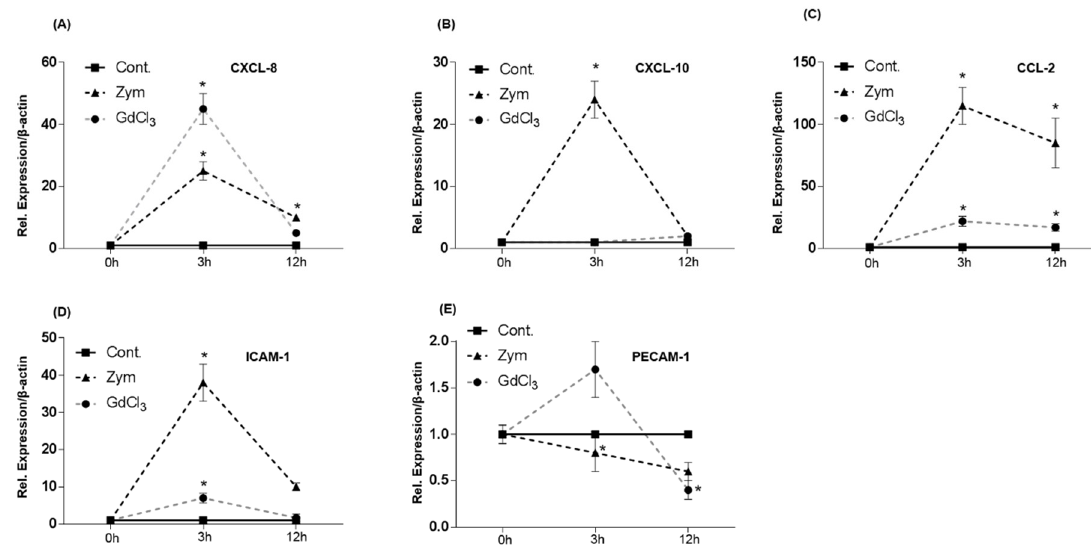
Figure 8. Fold change of mRNA expression of CXC-, CC-chemokines and adhesion molecules in intraperitoneally administrated GdCl 3 and Zymosan C3H/HeJ mice livers at different time points relative to controls. Maximum increase of CXCL-8 ( A ), CXCL-10 ( B ) and CCL-2 ( C ) gene expression is detected at 3 h by RT-PCR. Maximum increase of ICAM-1 ( D ) and PECAM-1 ( E ) gene expression is detected at 3 h by RT-PCR in Zymosan treated mice livers. The results were normalized to the housekeeping gene β -actin and experimental errors are shown as ± SEM values of six experiments (in duplicate) compared with controls for each time point (* p < 0.05, analyzed by one-way ANOVA).